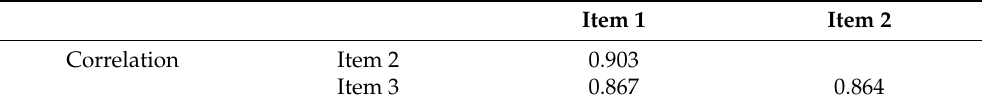
Table 2. Example of a correlation matrix with three items and their correspondence